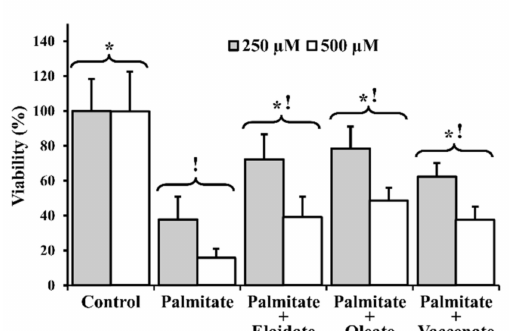
Figure 1. Cell viability. RINm5F insulinoma cells were treated with bovine serum albumin (BSA) (control cells) or BSA-conjugated palmitate alone, or with palmitate in combination with one of the unsaturated fatty acids, elaidate, oleate or vaccenate at two concentrations (250 or 500 µ M) as indicated at 70%–80% confluence and incubated for 24 h. Cell viability was measured by Colorimetric (MTT) Kit for Cell Survival and Proliferation (Millipore) and expressed as a percentage of the control. Data are shown as mean values ± S.D; n = 6; statistically significant di ff erences: ! p < 0.05, vs. BSA-treated control; * p < 0.05, vs. palmitate-treated cells.